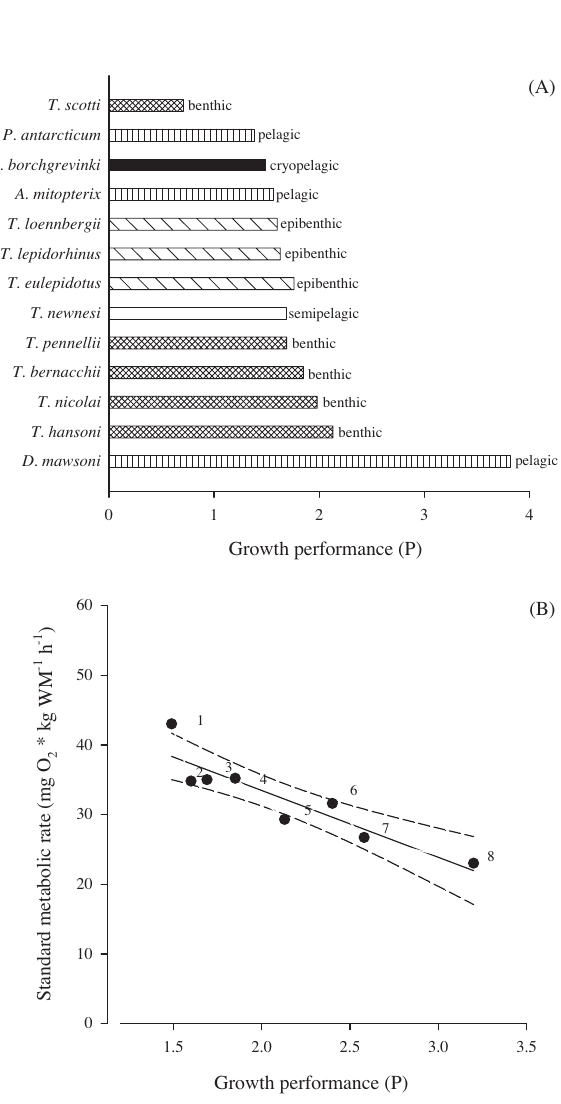
F IG . 2. – Overall growth performance ( P ) of notothenioid fish in relation to (A) their mode of life in the high Antarctic zone and (B) their standard metabolic rate (SMR) in the high Antarctic and less- er-Antarctic/Subantarctic zone. According to Pauly (1979) overall growth performance P (= log K + log M ) describes the growth rate ∞ at the point of inflection of the size (mass) growth curve (K, year -1 , is a measure of how fast fish attain their final size and M is the infi- ∞ nite mass of the fish, in g). (A) Graph redrawn using P values com- piled by La Mesa and Vacchi (2001). (B) P values by La Mesa and Vacchi (2001) and Hubold (1991), SMR: Holeton (1970), Forster et al . (1987), Johnston et al . (1991); Johnston and Battram (1993); Macdonald et al . (1988); Wells (1987) in Montgomery and Wells (1993); Morris and North (1984) in Thurston and Gehrke (1993); Zimmermann and Hubold (1998); Steffensen (2002); SMR values correspond to resting or standard metabolic rates, all expressed as mg O kg WM -1 h -1 (WM = wet mass) calculated for a 100 g fish at 2 temperatures close to freezing. SMR values of one species from various citations were summarised to one mean. Linear regression: y = -9.6 x + 52.6 (r = 0.91); dashed lines indicate the 95% confi- dence interval. High-Antarctic species are: 1 Pagothenia borch- grevinki (cryopelagic, active under sea ice), 2 Trematomus loennbergii (demersal), 3 T. pennellii (demersal), 4 T. bernacchii (demersal), 5 T. hansoni (demersal), Lower- to Subantarctic species: 6 Notothenia neglecta (benthopelagic), 7 N. gibberifrons (benthopelagic), 8 N. rossii